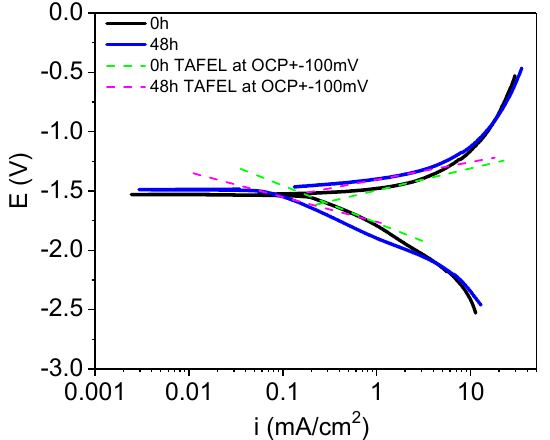
Figure 9. Linear polarization curves of EZ51-IM350 of freshly prepared specimen immediately after immersion and the specimen immersed in PBS solution during 48 h. Tafel fittings at ± 100mV OCP are also depicted. Table 2. Parameters measured (E corr , R p ) and calculated ( β , B, graphical i corr1 and corrosion rate ( P i1 ) from the linear polarization curves of Figure 9 for EZ51-IM350 alloy. R p value from EIS experiments and B = 45 mV were taken for the calculation of i corr2 and P i2